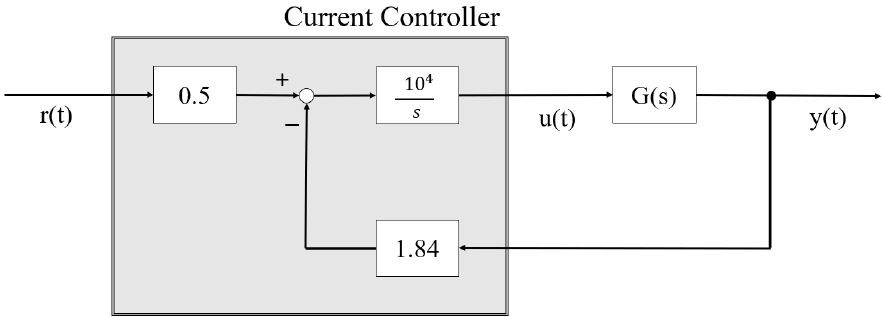
Figure 3. Block diagram of the constant current control circuit of the ADB-5410.